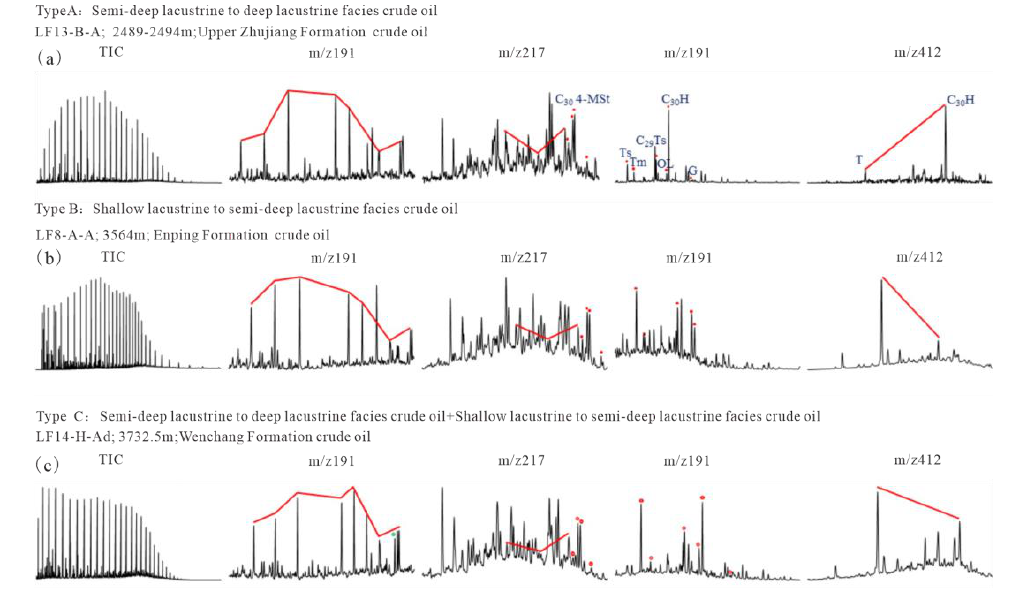
Figure 6. Characteristics of the biomarker of the three types of crude oil in the southern Lufeng region: ( a ) type A semi-deep lacustrine to deep lacustrine facies crude oil; ( b ) type B shallow lacustrine to semi-deep lacustrine facies crude oil; ( c ) type C mixed crude